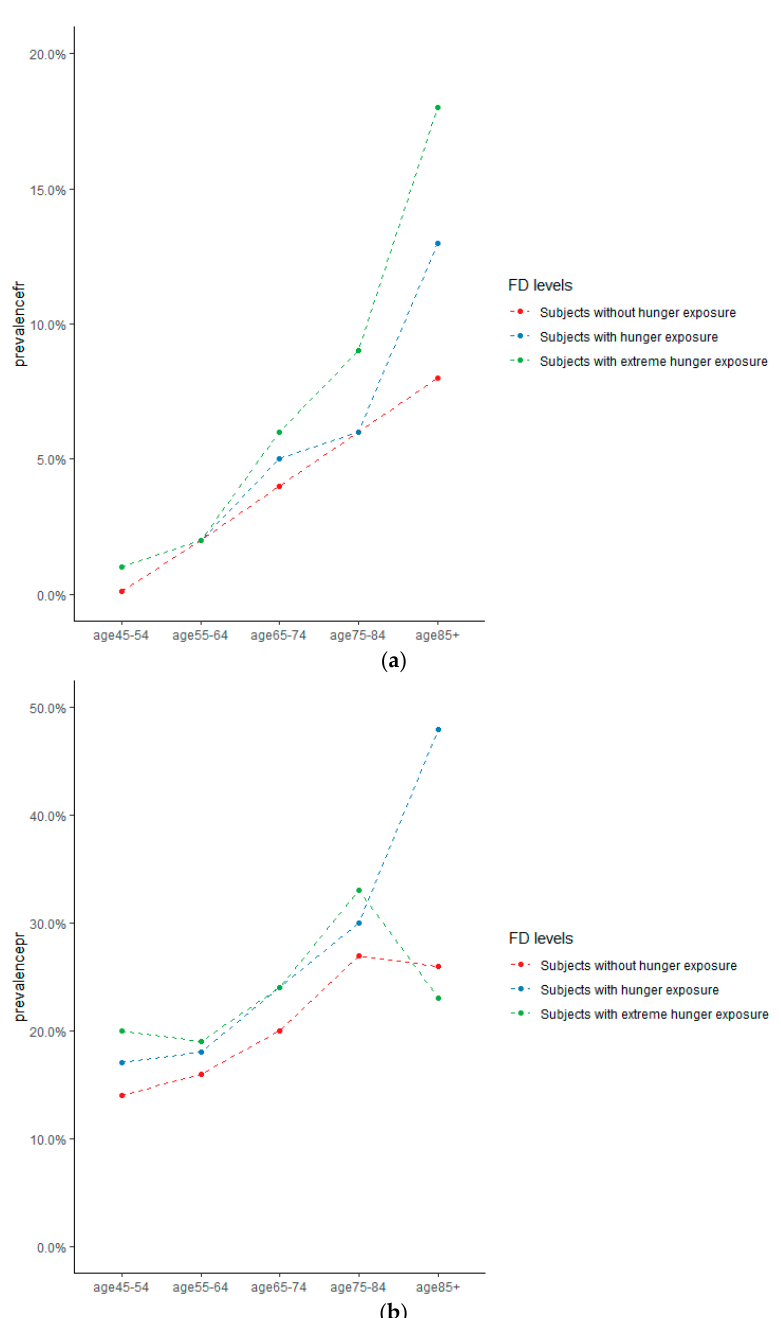
Figure 2. ( a ) Prevalence of frailty in China, by age and hunger exposure; ( b ) Prevalence of pre-frailty in China, by age and hunger exposure.